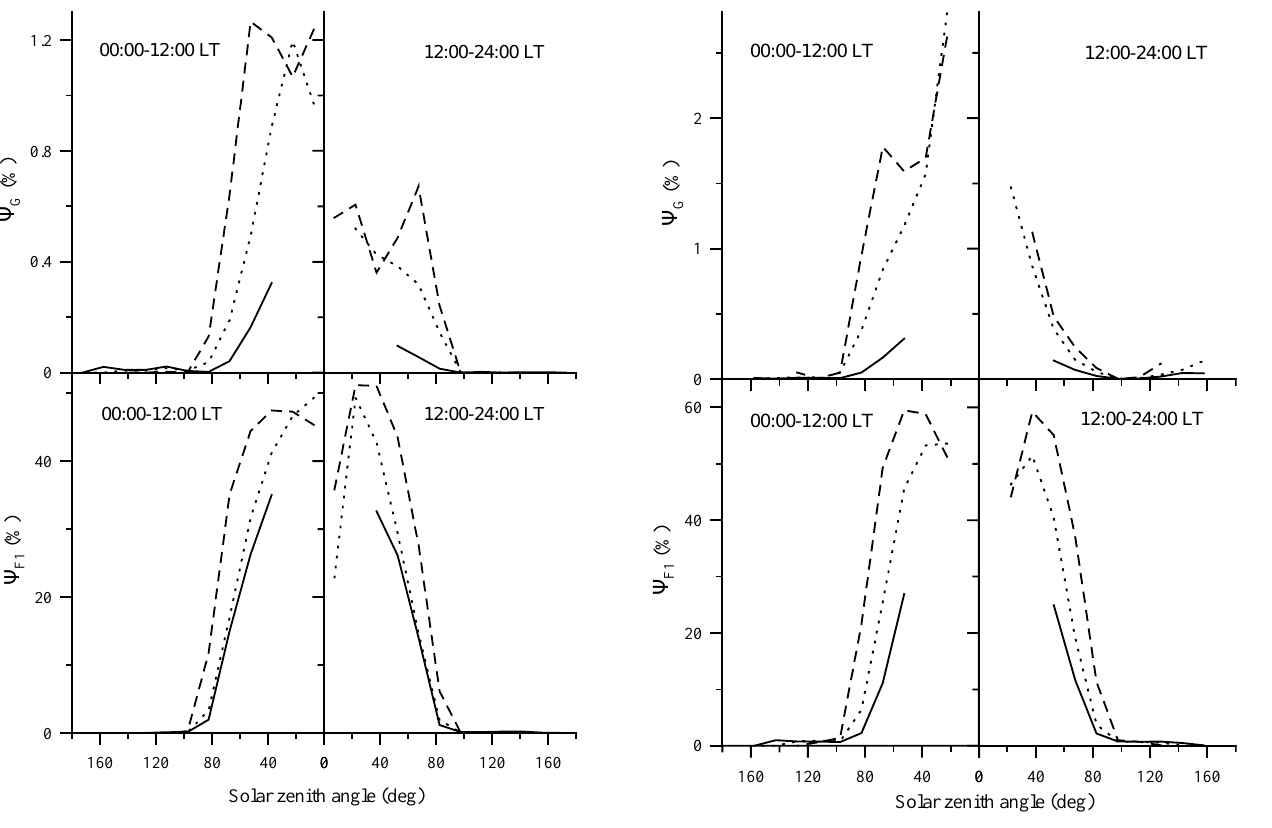
Fig. 4. The dependence of the F1-layer (bottom panels), and G con- dition (top panels) probability functions on the solar zenith angle in latitude range 4 (45 ◦ < | ϕ | ≤ 60 ◦ , 45 ◦ < | 8 | ≤ 60 ◦ ) during the winter (solid lines), summer (dashed lines), and spring and autumn (dotted lines) months before midday from 00:00LT to 12:00LT (left panels), and after midday from 12:00LT to 24:00LT (right